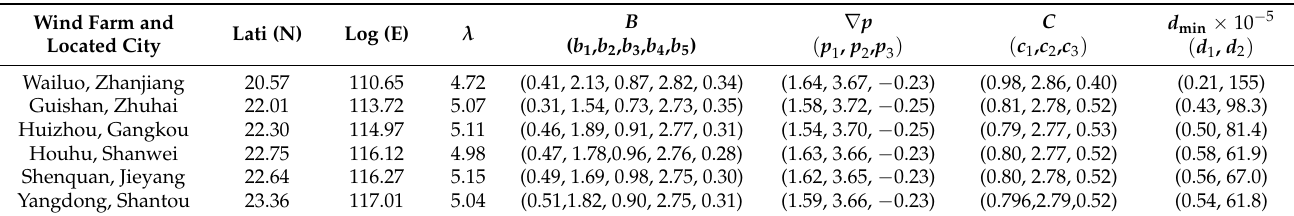
Table 2. Parameters of fitting function for typhoon key parameters of six representative OWF in Guangdong Province.